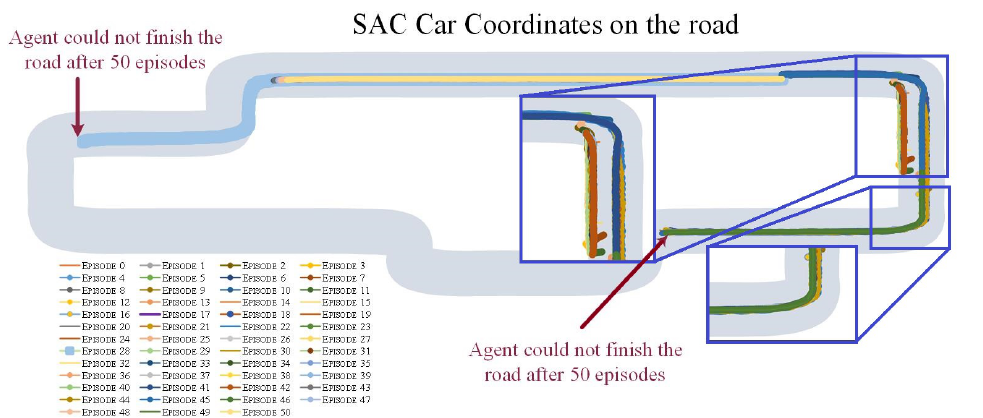
Figure 7. Baseline SAC: the car’s trajectory on the roadway for the first 50 episodes of training by the SAC algorithm. Two zoomed-in overlays show details of some busy parts on the road.